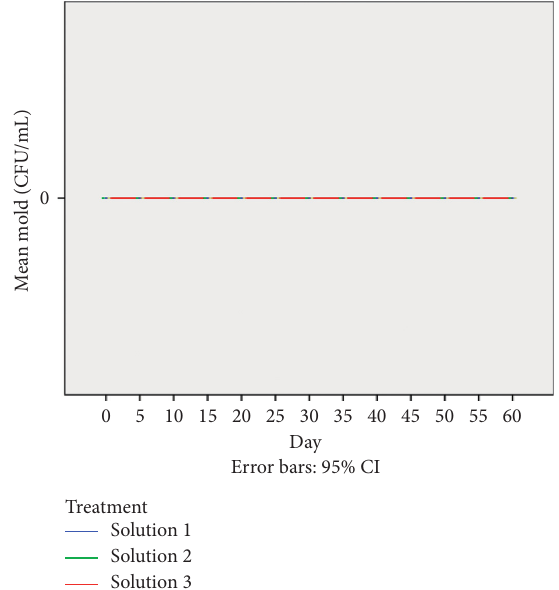
Figure 5: Changes (means ± SD) in mold count of antimicrobial edible coating solutions: solution 1 (0.250 g/L Delvocid), solution 2 (0.275 g/L Delvocid), and solution 3 (0.300 g/L Delvocid) during the storage at 8 ° C and 85%